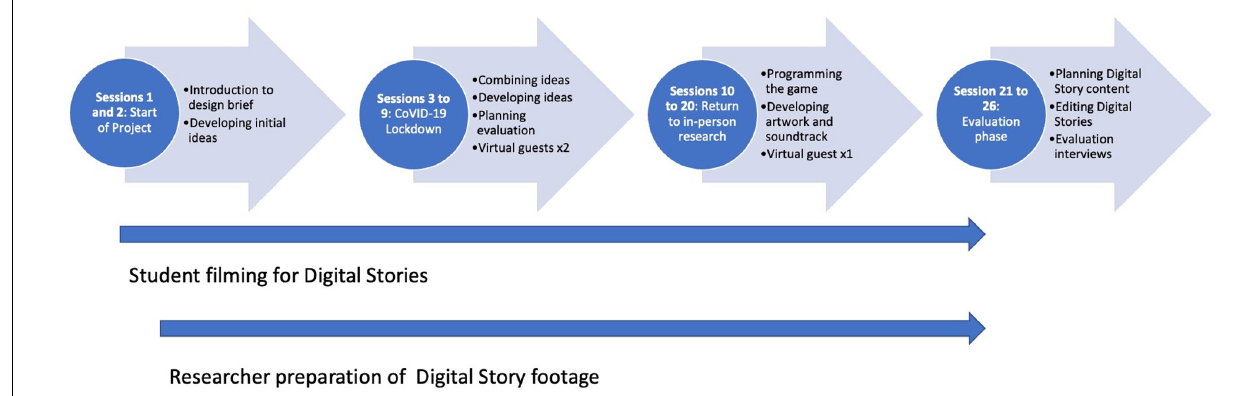
FIGURE 2 | Timeline of research